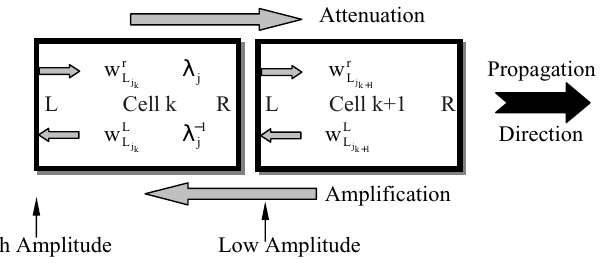
Fig. 5. Attenuation of right and left-going waves in the propagation